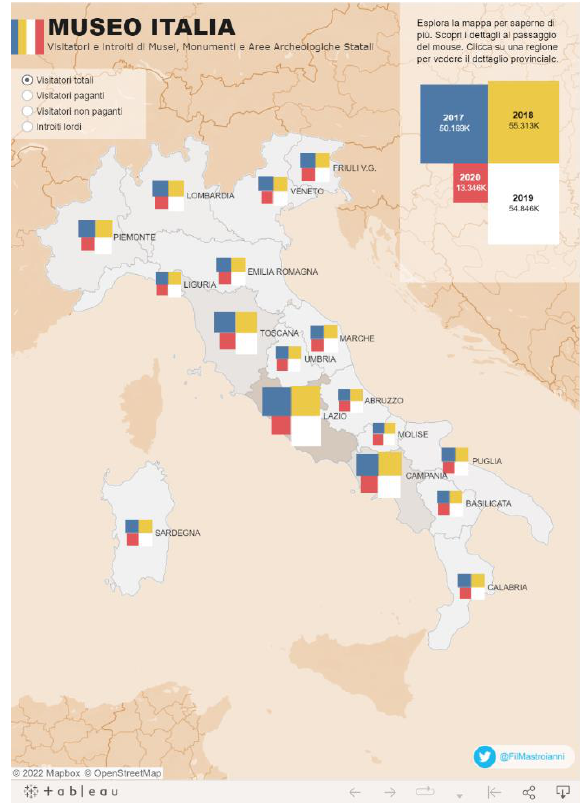
Figure 1. Visitors and income from museums, monuments and state archaeological sites. Source: Il Sole 24 Ore (https://www.infodata.ilsole24ore.com/2021/05/23/la-crisi-dei-